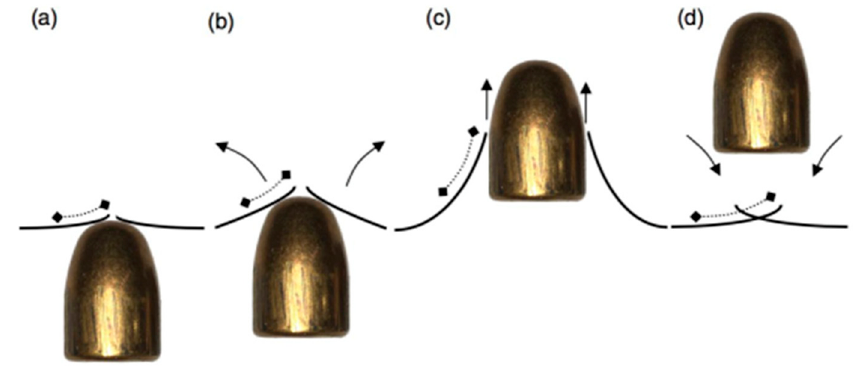
Figure 1. Perforation and healing process.